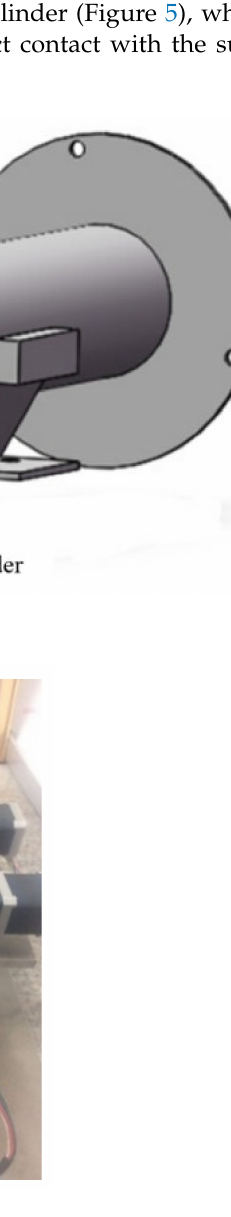
Figure 6. Rendering of the installing